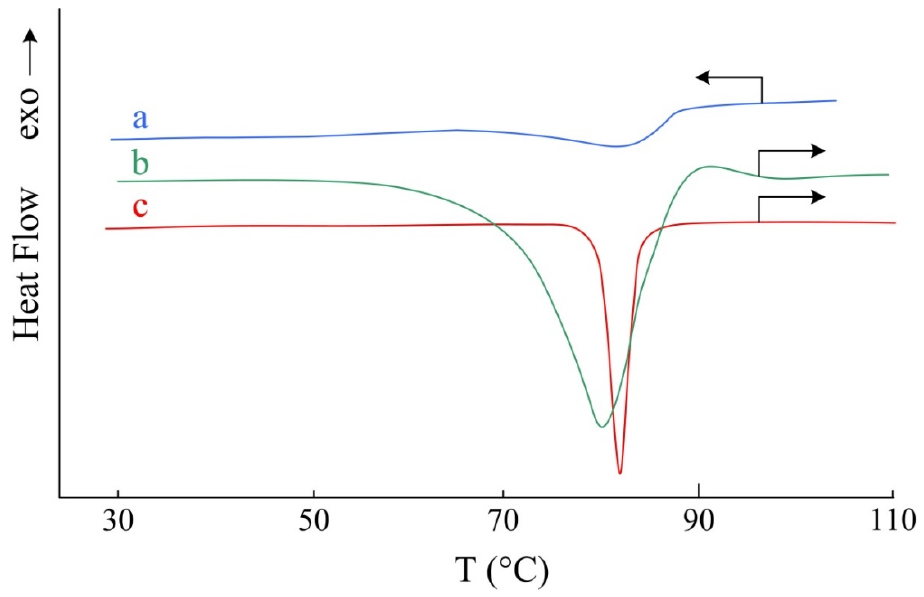
Figure 4. DSC curves of APP: heating before recrystallization ( b ) and after recrystallization ( c ) and cooling ( a ).